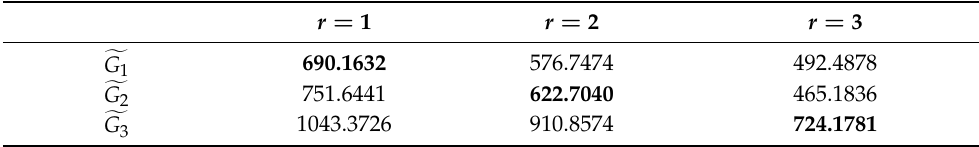
Table 6. Values χ ir of the convex problem (bold numbers are the optimal